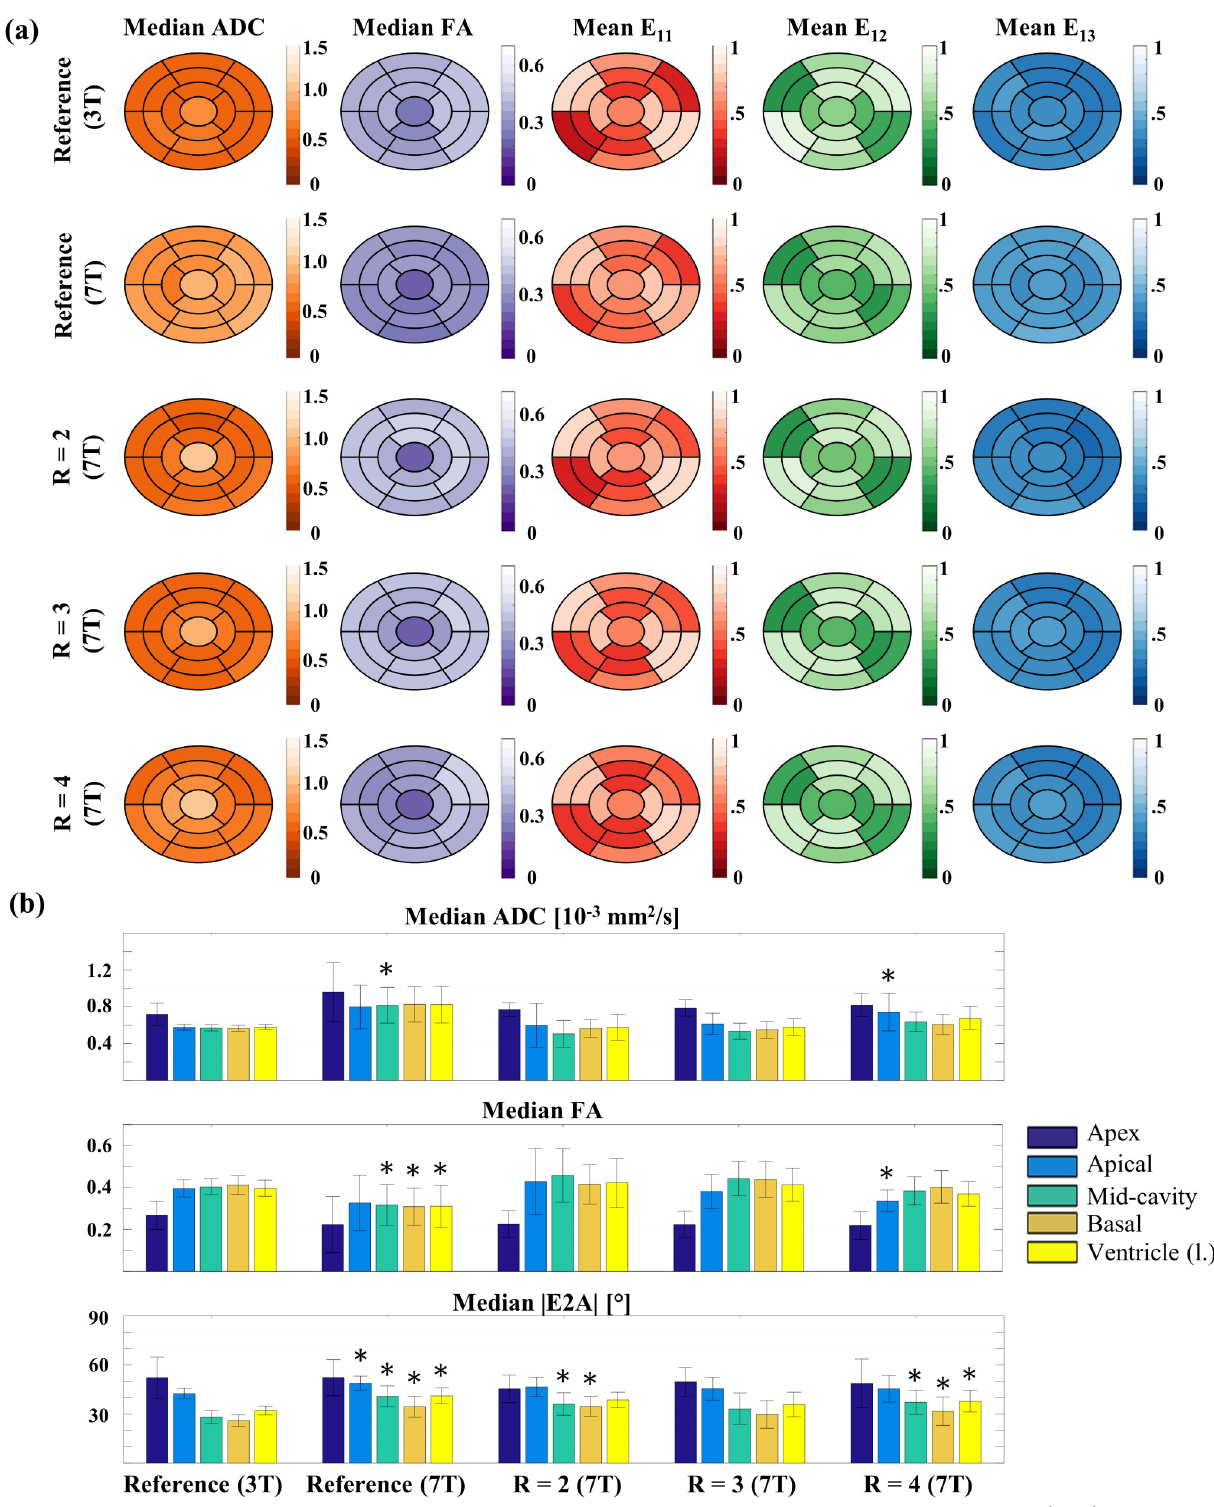
Fig 4. 17 segment distributions of diffusion metrics at 3 T and 7 T using varying parallel imaging factors. (a) Median ADC [10 − 3 mm 2 /s], FA, and the three main eigenvector E 1 components E 11 , E 12 , E 13 for all 17 segments. Color coding of the vector components corresponds to the “RGB” encoding of spatial orientation for diffusion tensor main axes typically used in DTI (see Fig 1). (b) Values of median ADC, FA and |E2A| averaged for apex, apical,